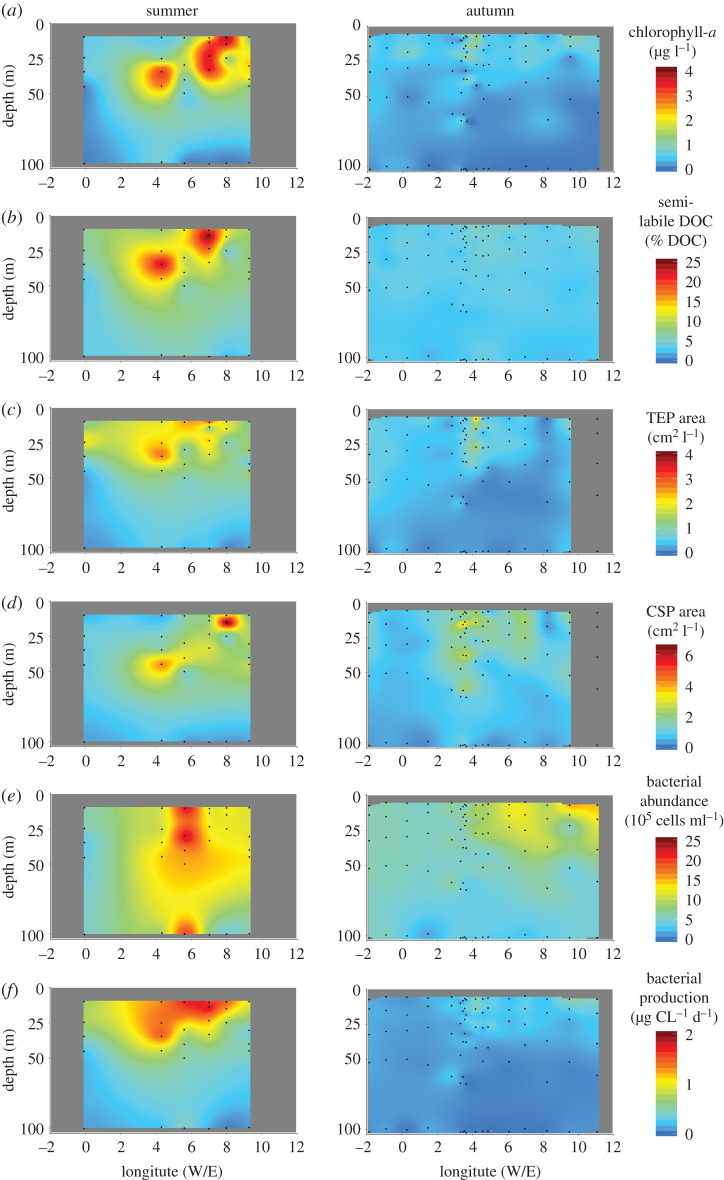
Spatial variability along the approximately 79°N latitude in the Fram Strait during the summer (left) and autumn (right) of 2018. The parameters shown include (a) chlorophyll-a, (b) semi-labile carbon, area of (c) TEP and (d) CSP, (e) bacterial abundance and (f ) bacterial production (BP). No data are available for the grey shaded region; stations not shown include: N3-N5, NSB1, S3, R1 (electronic supplementary material, table S1). (Online version in colour.)